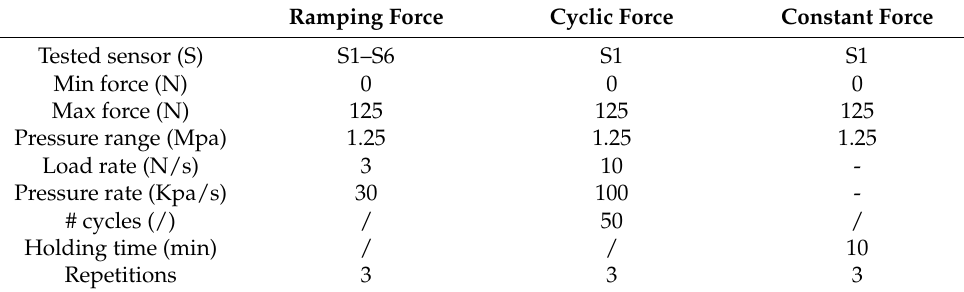
Table 3. Details of the sensor testing Table 4. Details of the sensor testing methodology.